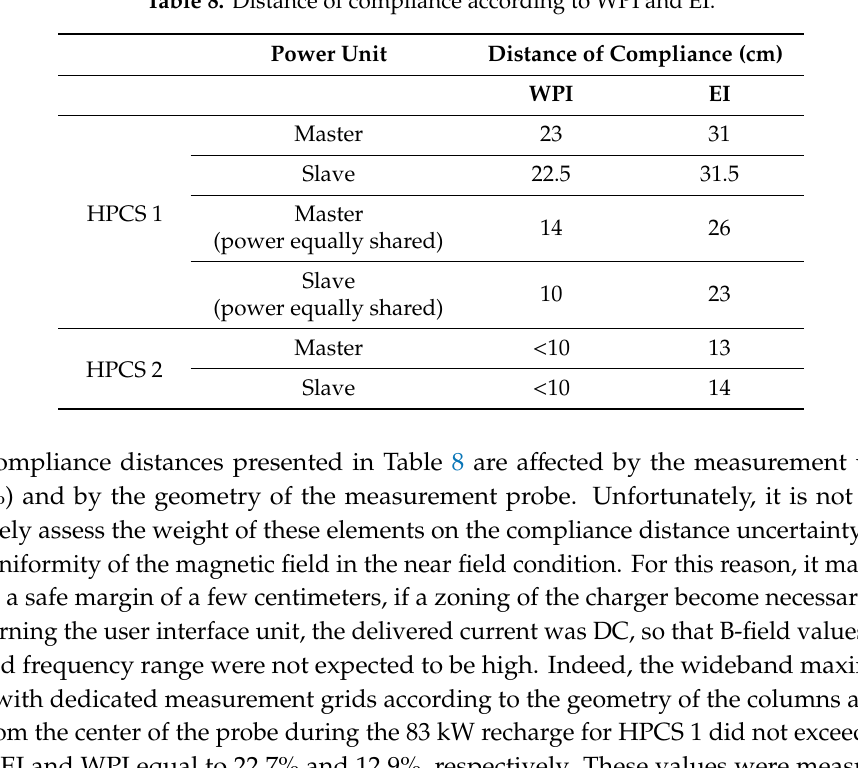
Table 8. Distance of compliance according to WPI and